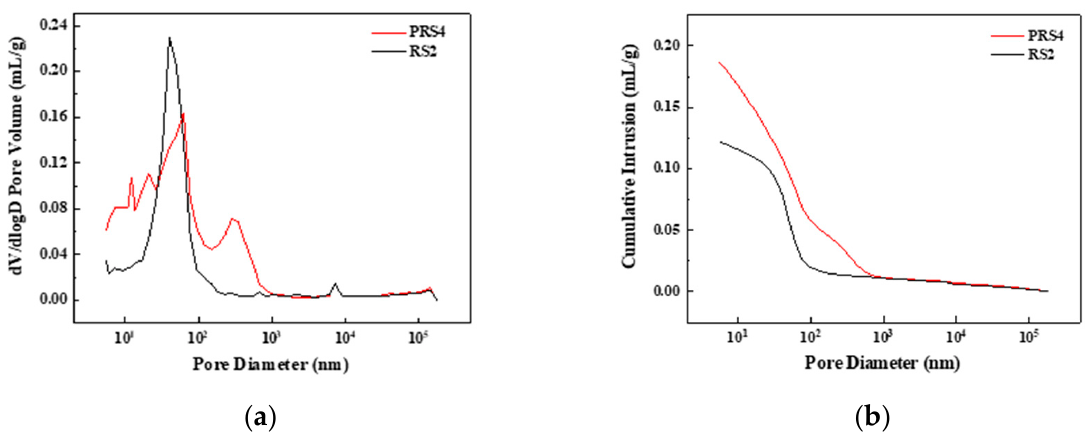
Figure 5. MIP analysis of porous reconstructed steel slag foaming with SiC. ( a ) Pore size distribution; ( b ) Cumulative intrusion. Table 5. Pore structure changes of reconstructed steel slag before and after SiC foaming.